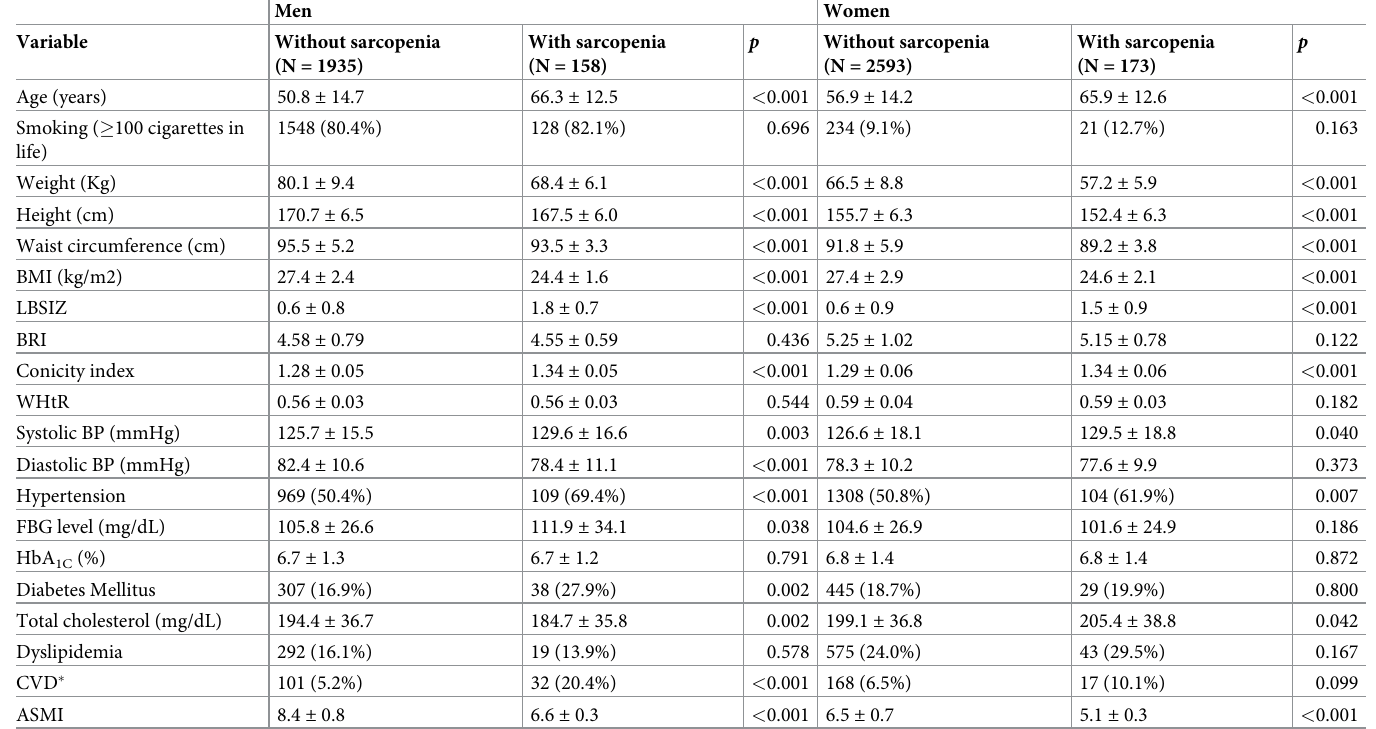
Table 2. Characteristics of the participants in KNHANES according to sex and sarcopenia.